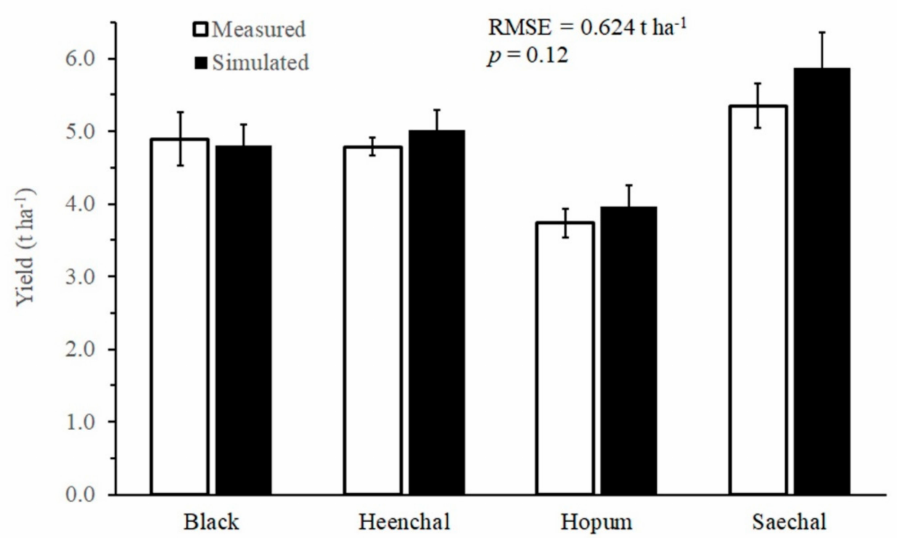
Figure 5. Comparison between simulated and measured grain yields of four barley cultivars at Chonnam National University, Gwangju, South Korea in 2018 for model calibration. RMSE, NSE, and p stands for root mean square error, Nash–Sutcli ff e e ffi ciency, and p ( α = 0.05) at a two-sample t -test. Vertical bars represent SE of each mean value ( n =